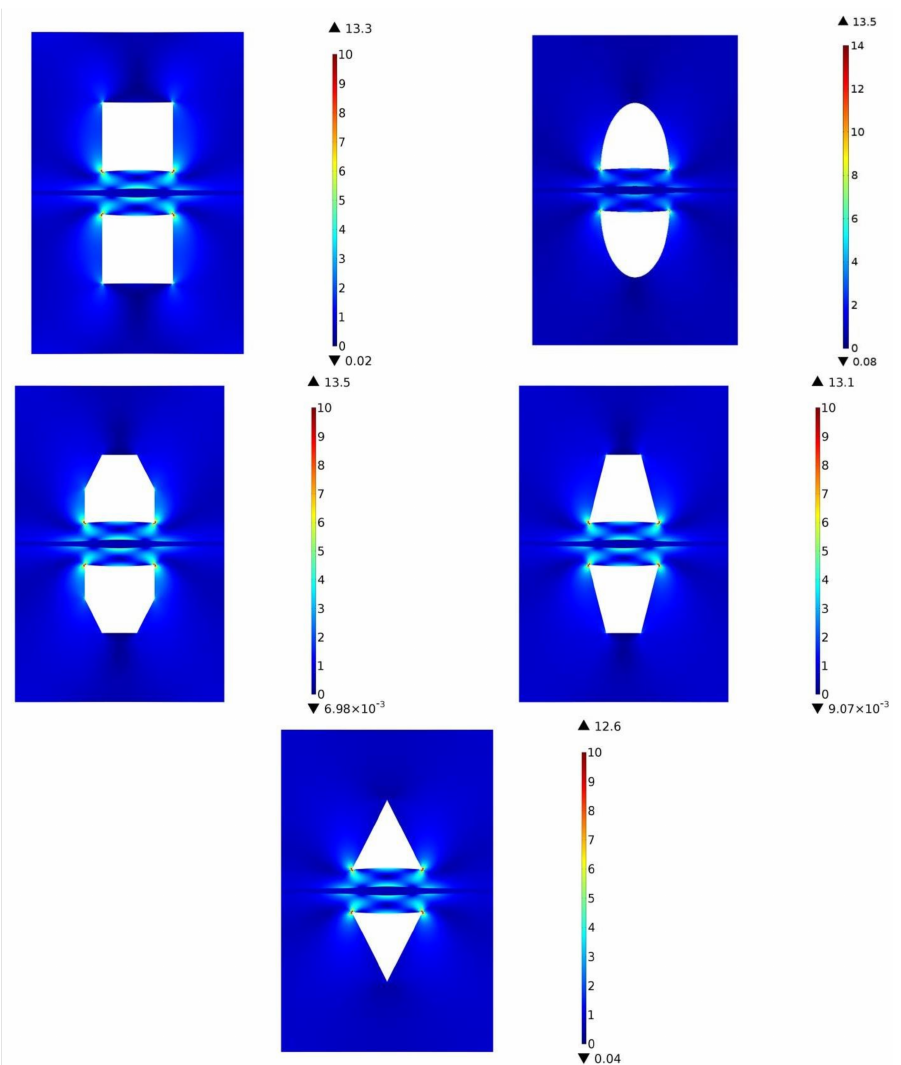
Figure 9. von Mises stress variations (MPa) in the PEM-FC through the process of assembly at height = 1 mm, with scale increased 50